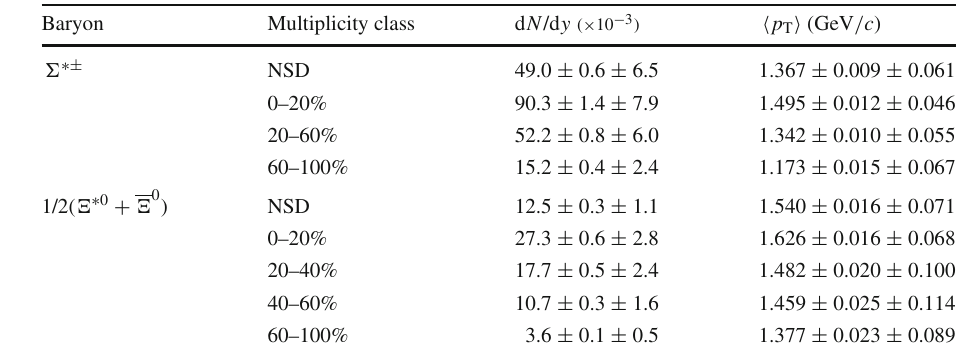
Table 6 Integrated yields